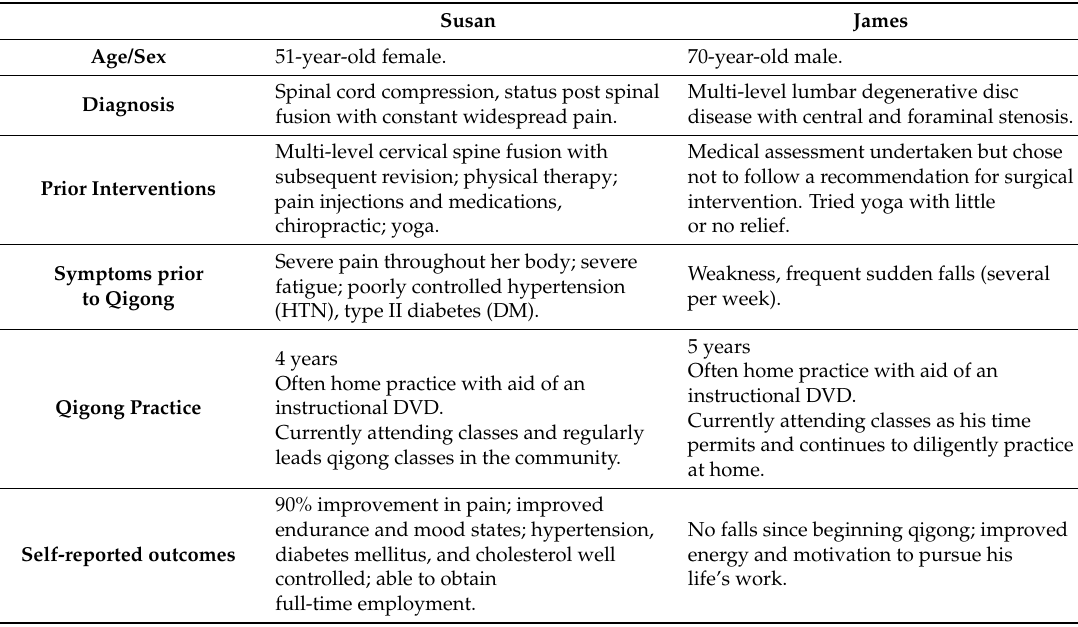
Table 1. Comparative description of two cases